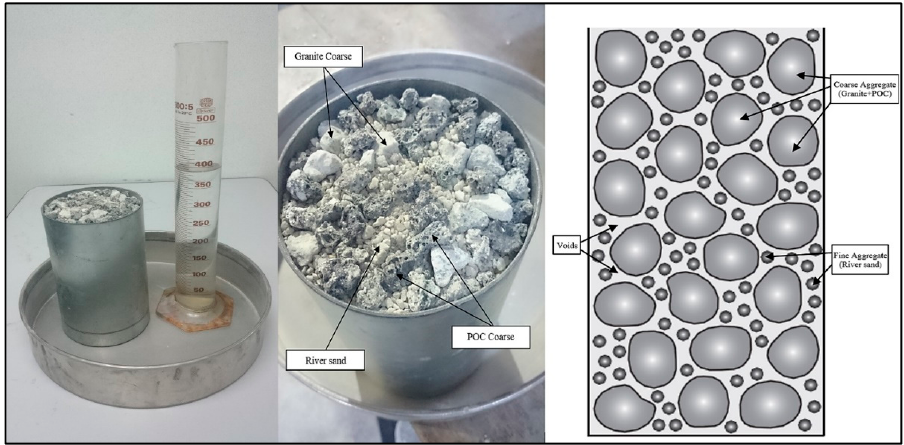
Figure 5. Schematic diagram of PP test.